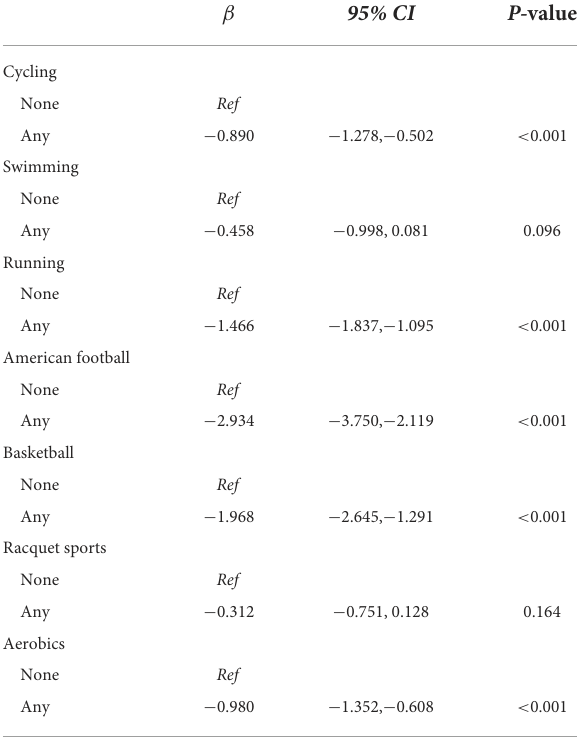
TABLE 2 Associations of specific types of physical activities participation with CVD risk in adults aged ≥ 30 years *